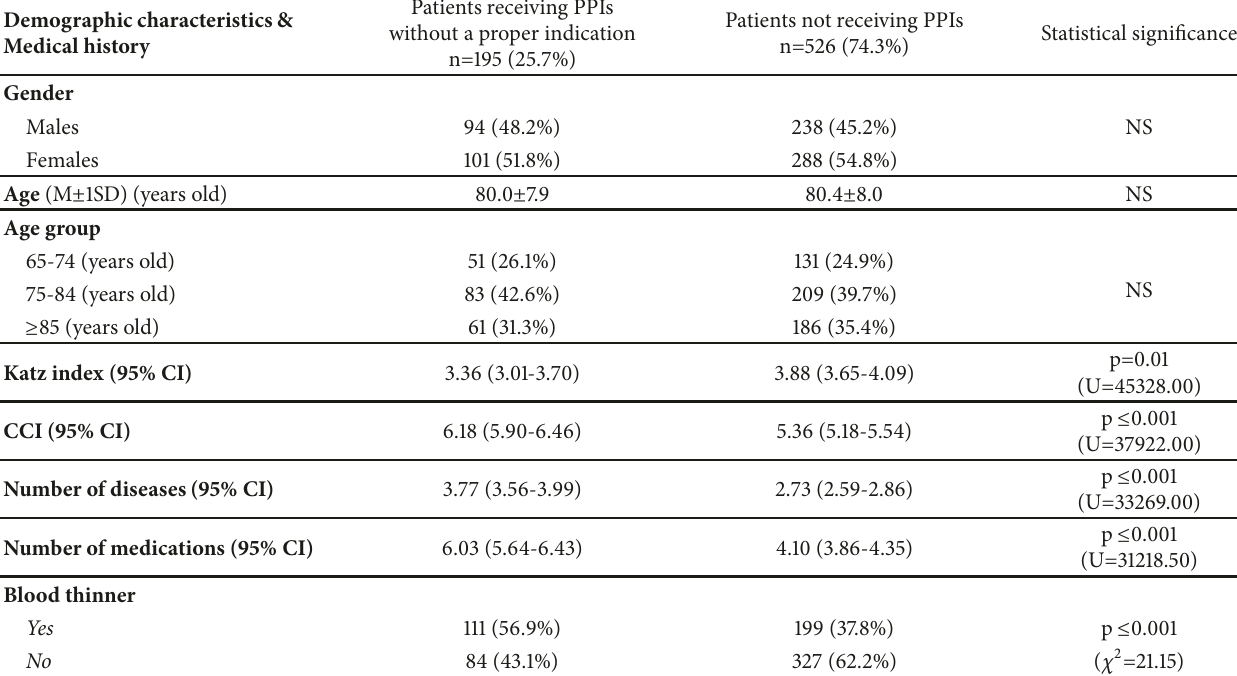
Table 1: Comparison of demographic and medical history differences between patients receiving PPIs without a proper indication and patients who were not receiving PPIs.